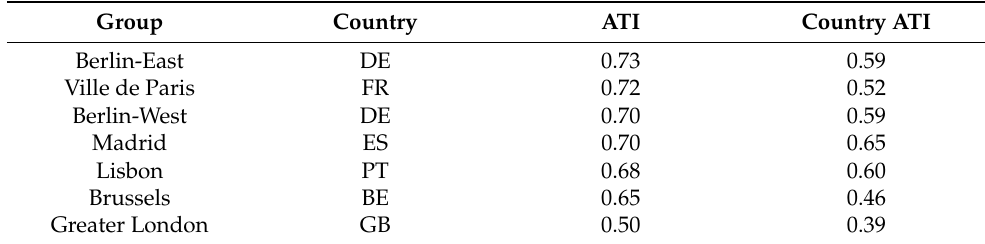
Table 5. ATI Capital